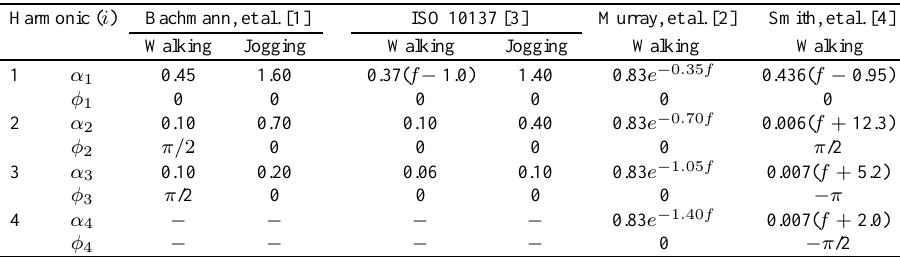
Table 1 Values of α i and φ i for the walking/jogging force excitations from different sources